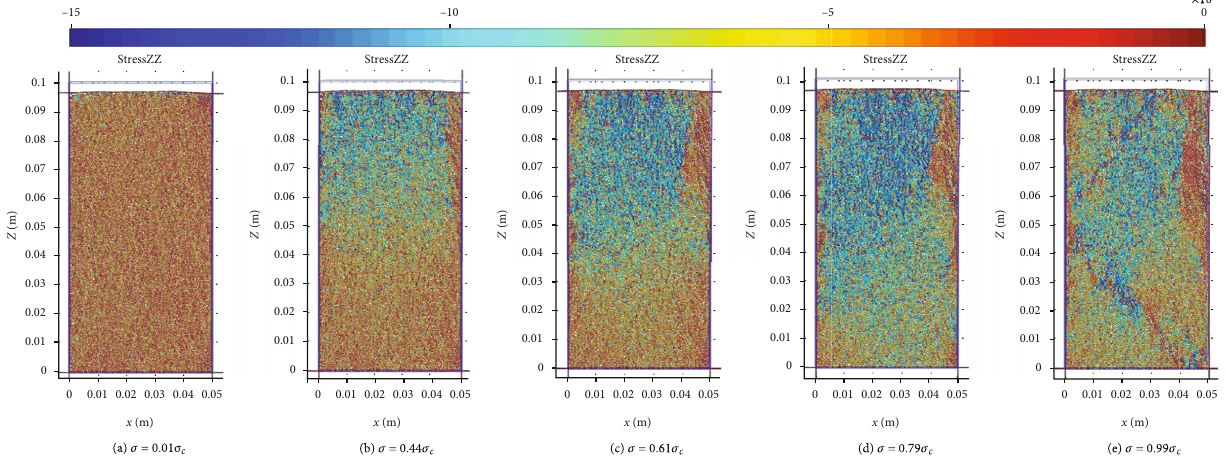
Figure 8: Axial stress distribution of particles under di ff erent stress levels in gas-containing coal.